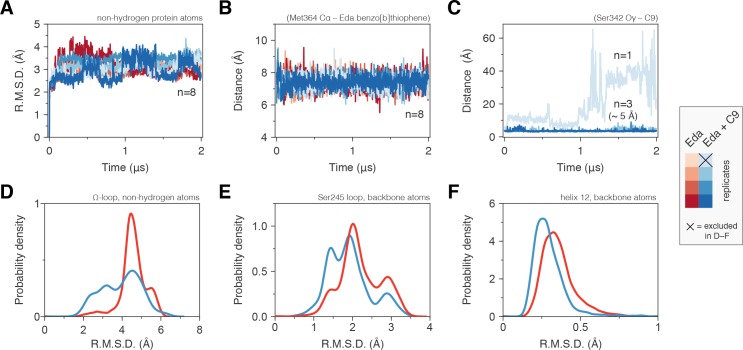
Molecular simulations reveal C9 cobinding stabilizes the PPARγ LBD.(Α) Heavy atom R.M.S.D. to the starting conformation (crystal structure after minimization and equilibration) reveal that all four simulations bound to edaglitazone only to the orthosteric site (red lines) or cobound to C9 at the alternate site (blue lines) are stable during the simulation period. (B) Distance between benzo[b]thiophene group in edaglitazone and the M364 Cα atom shows that edaglitazone remains stably bound to the orthosteric pocket in all eight simulations. (C) C9 remains stably bound to the alternate site in three of four cobound simulations. In the legend, the × denotes the Eda + C9 (light blue) simulation where C9 unbound during the simulation, which was excluded from the analysis. (D–F) Probability density histogram distributions of the R.M.S.D. relative to the starting structure for (D) the Ω-loop, (E) the loop containing the serine residue phosphorylated by Cdk5, and (F) helix 12. Also see
Figure 6—figure supplement 1.